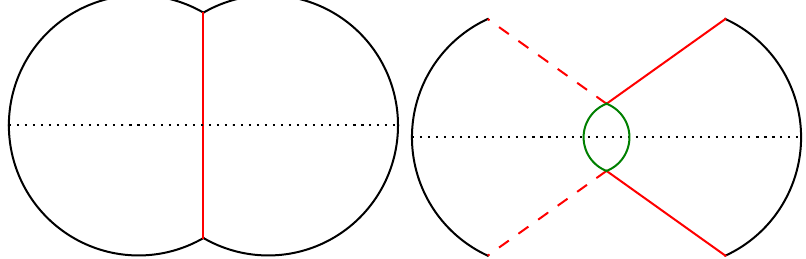
Figure 1 . Schematic . Left: a freely propagating brane in Euclidean AdS 2 . Right: the bounce solution for the decay of the brane into a dS bubble. The dashed red lines on the left have to be identi(cid:12)ed with the solid red lines on the right. The diagrams can be cut at the moment of time-re(cid:13)ection symmetry (along the dotted lines) and Wick rotated to Lorentzian